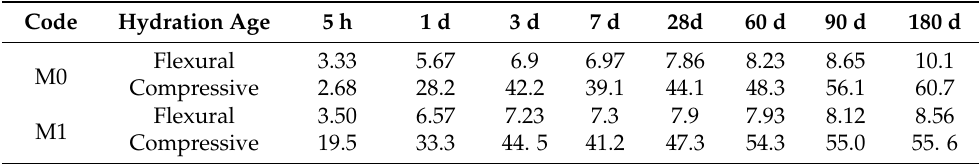
Table 2. Strength development of MKPC paste specimens in a curing chamber